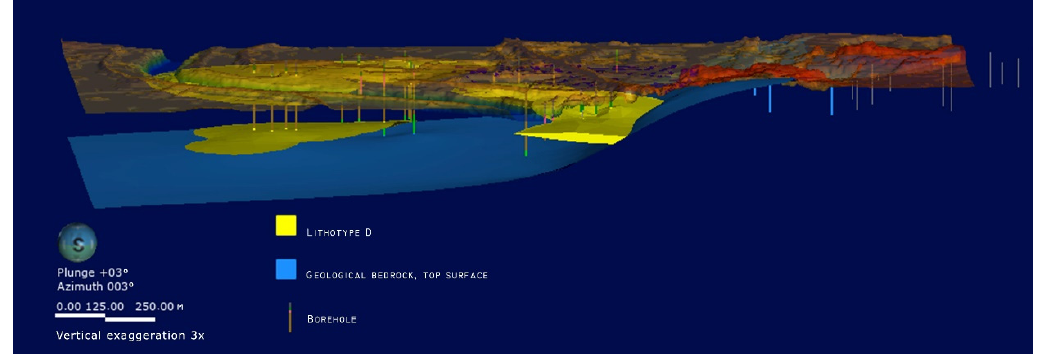
Figure 8. Three-dimensional model of the top surface of the geological bedrock with lithotype D lenses and location of the boreholes. View from the South. lenses and location of the boreholes. View from the